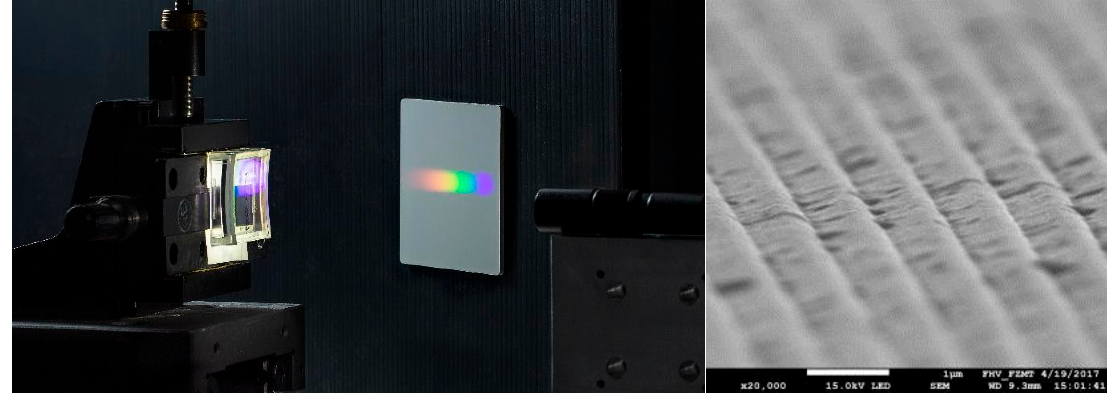
Figure 3. Diffraction effect of the grating illuminated with a LED-flashlight ( left ) and a SEM image of the surface of a nickel cast ( right